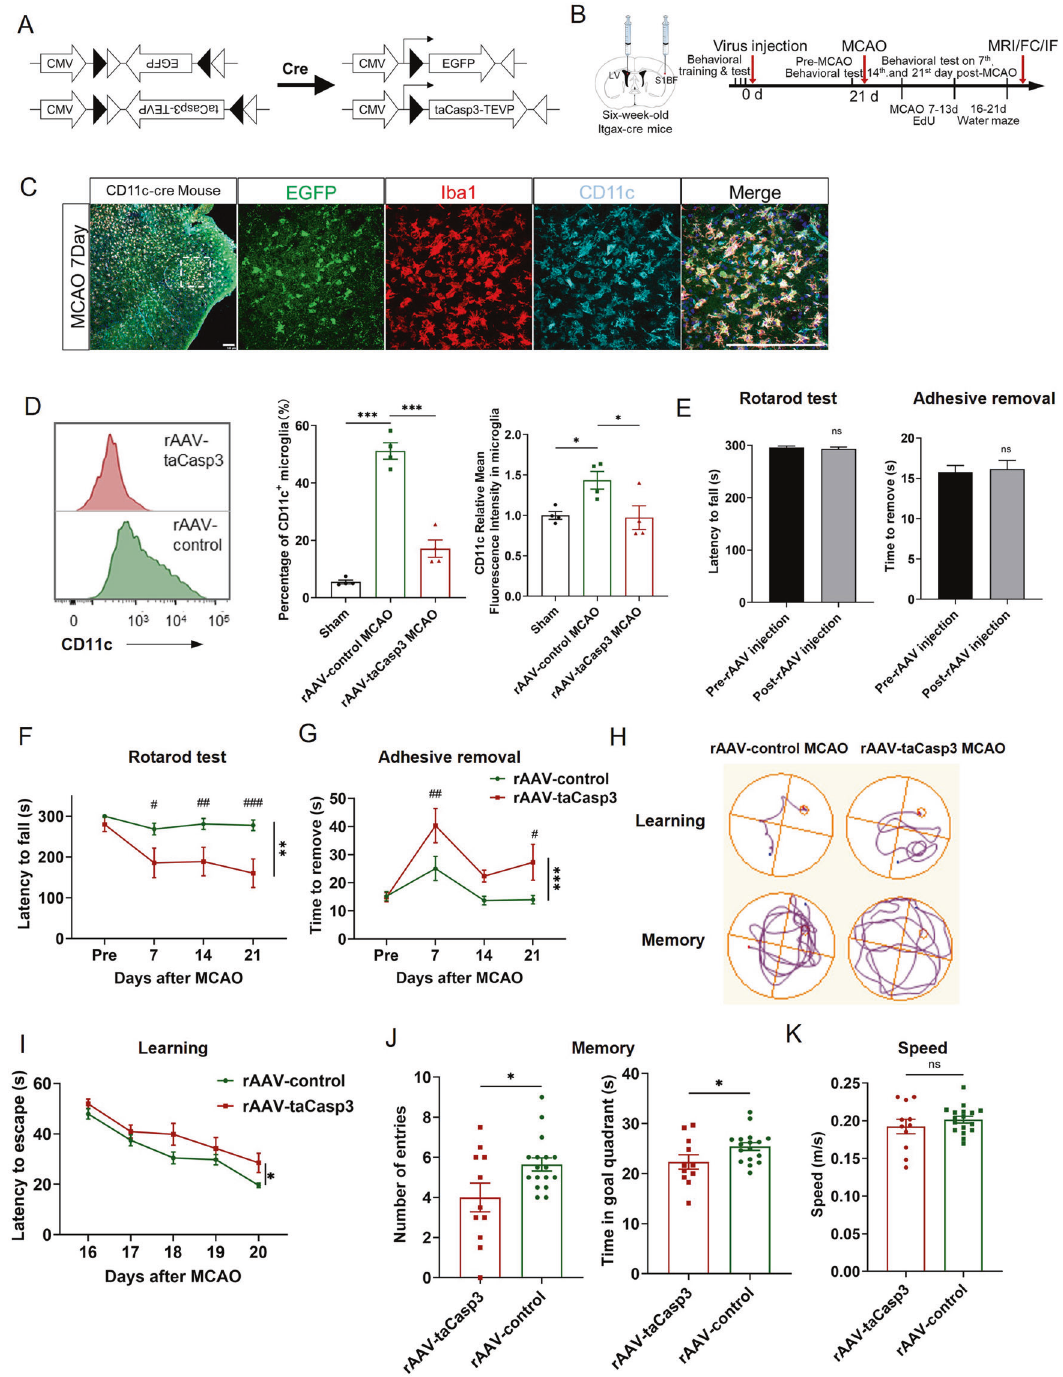
Fig. 6 Depleting CD11c + microglia in the late phase of stroke impaired functional recovery. A A schematic illustration of the Cre-DIO system. B Experimental design for CD11c + depleted mice and their controls. C Immunostaining of CD11c-cre mice with rAAV-DIO-EGFP injection 3 weeks before tMCAO and subjected to tMCAO 7 days. Scale bars 100 μ m. D Representative fl ow cytometric analysis for mice with rAAV-taCasp3 or rAAV-control injection 3 weeks before tMCAO and subjected to tMCAO 21 days. Percentage of CD11c + microglia and relative CD11c fl uorescence intensity of microglia in sham, rAAV-control group, and rAAV-taCasp3 group respectively ( n = 4 per group). Stereotactic injections of rAAV did not affect the motor and sensory function of intact mice ( n = 36). E Depleting CD11c + microglia deteriorated long-term motor and sensory de fi cits after tMCAO as assessed by rotarod test ( F ) and adhesive removal ( G ) tests. n = 17 for rAAV-control group and n = 11 for rAAV-taCasp3 group. # p < 0.05, ## p < 0.01, ### p < 0.001 compared between rAAV-control and rAAV-taCasp3 group on each day. H Representative images showed the swim paths in the Morris Water Maze. Cognitive functions including training test for learning ( I ), probe test for memory ( J ), and speed ( K ) were evaluated in the Morris Water Maze. n = 17 for rAAV-control group and n = 11 for rAAV-taCasp3 group. * p < 0.05, ** p < 0.01, *** p < 0.001, and ns not signi fi cant. Values were mean ±